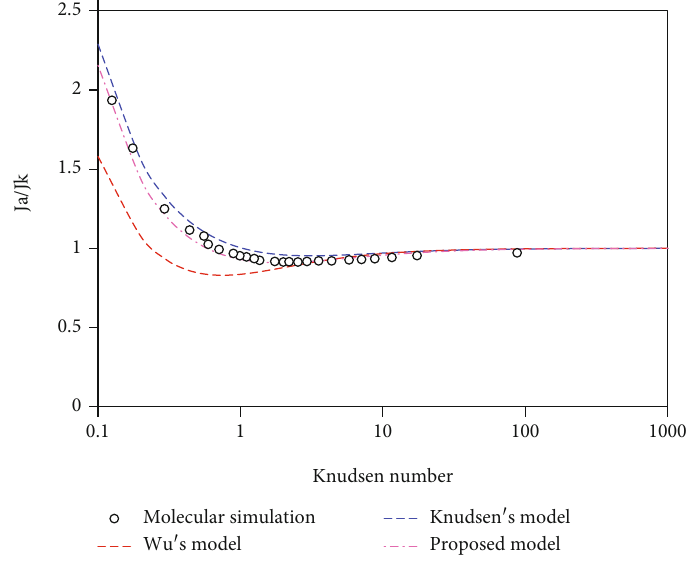
Figure 2: Comparison between proposed model and molecular simulation with high Kn .